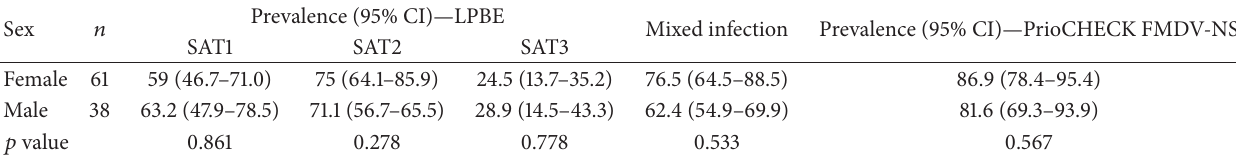
Table 3: Prevalence of LPBE results, mixed infection, and PrioCHECK FMDV-NS results in buffalo according to sex category.